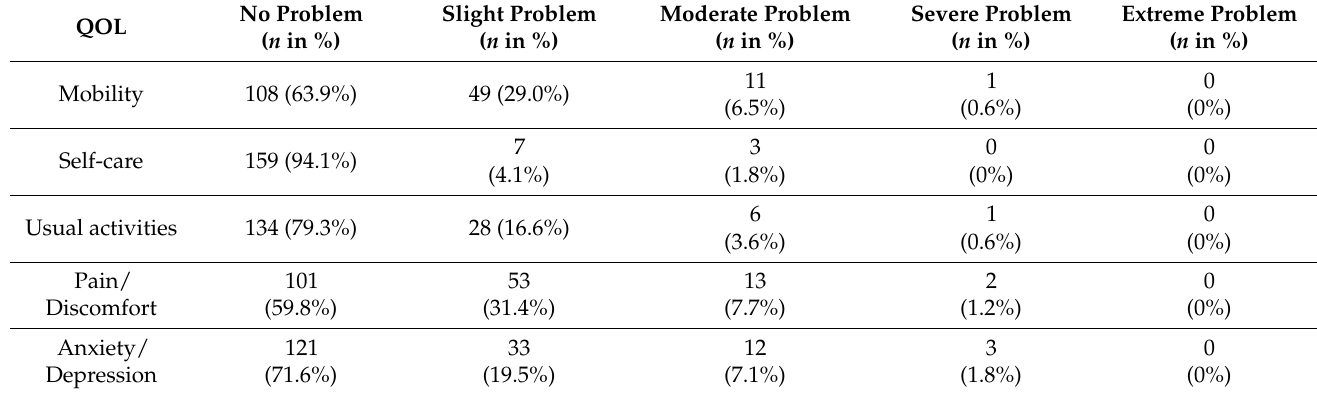
Table 4. Quality of life (QOL) outcomes (EQ-5D-5L) for patient.